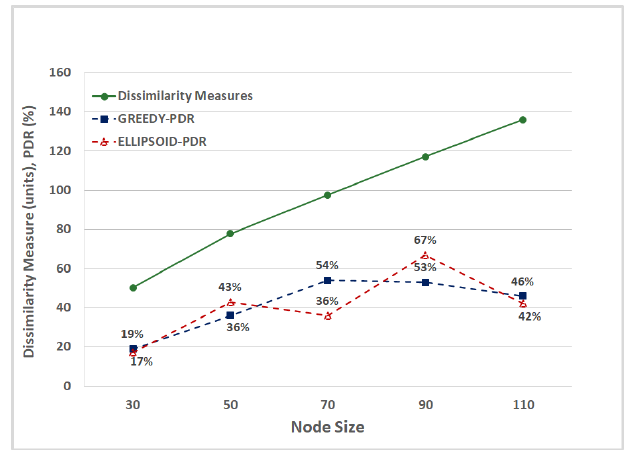
Figure 4. Dissimilarity distribution of the packet forwarding distance averages; and the PDR. (VANET